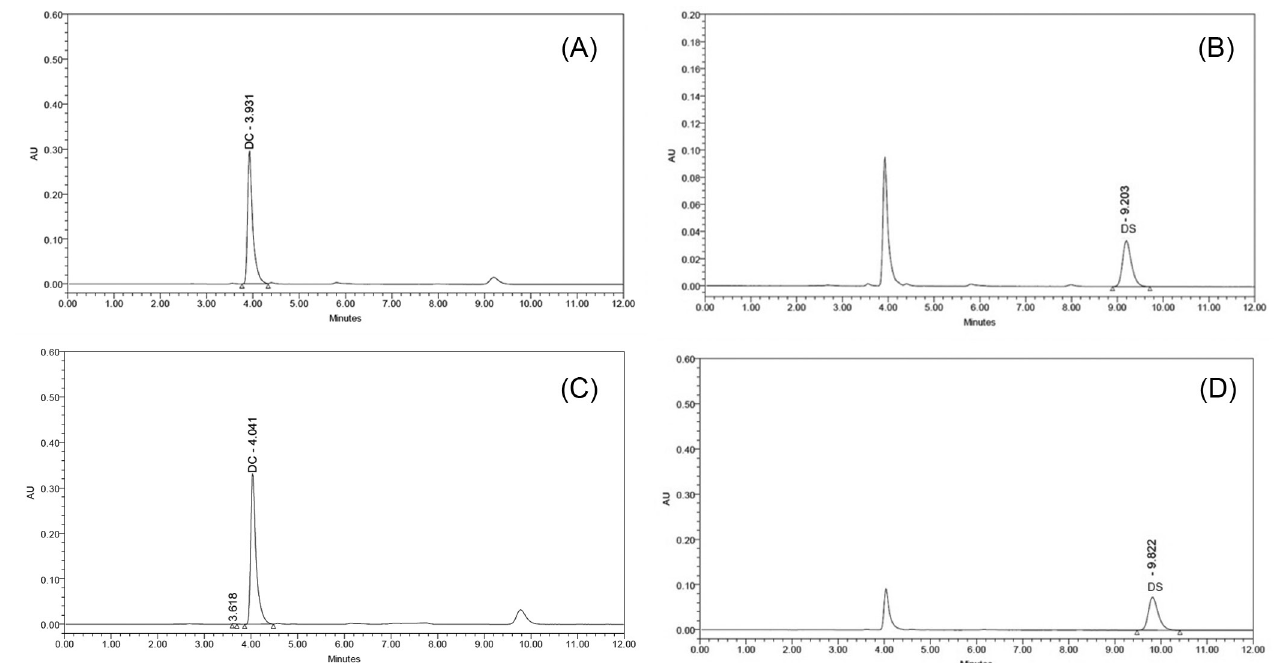
FIGURE 7 - Representative chromatograms of DC at 257 nm (A) and DS at 274 nm (B), chromatogram of DC from sample formulation (C) and DS from sample formulation